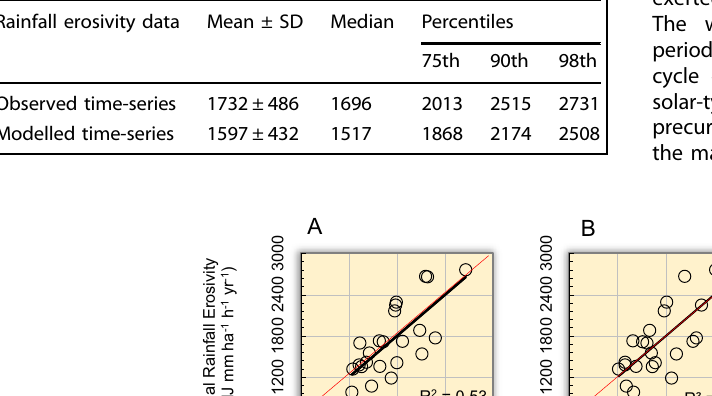
Table 1. Descriptive statistics (MJ mm ha − 1 h − 1 yr − 1 ) of the observed and modelled time-series of rainfall erosivity (1981 – 2015 CE).